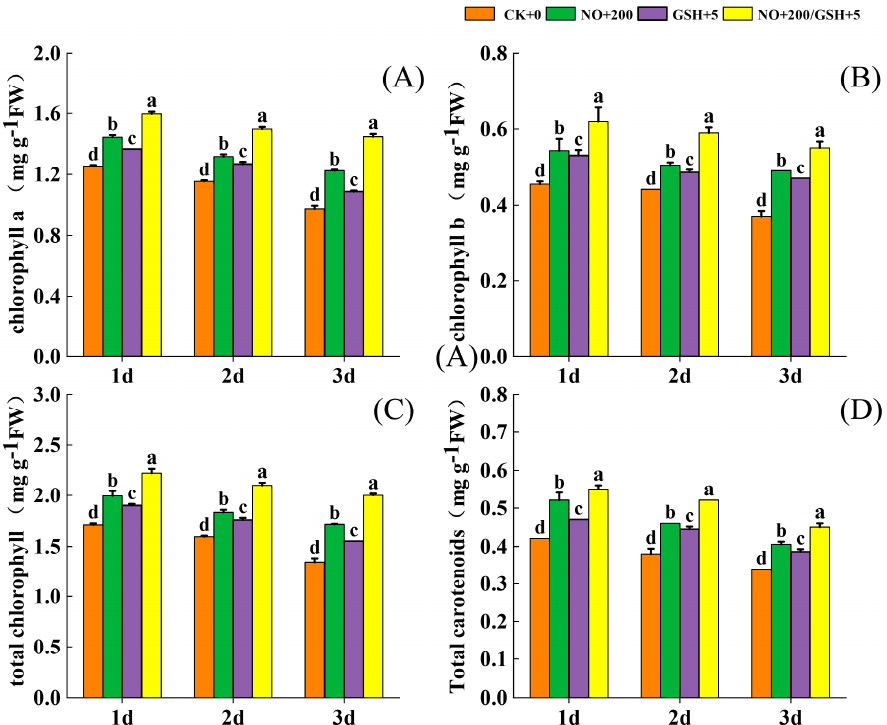
Figure 4. Effects of NO and GSH on photosynthetic pigment (( A ): chlorophyll a, ( B ): chlorophyll b, ( C ): total chlorophyll, ( D ): carotenoid) contents of cowpea seedlings under low-temperature stress. Different letters indicate statistically significant differences according to Duncan's multiple range test at p < 0.05.